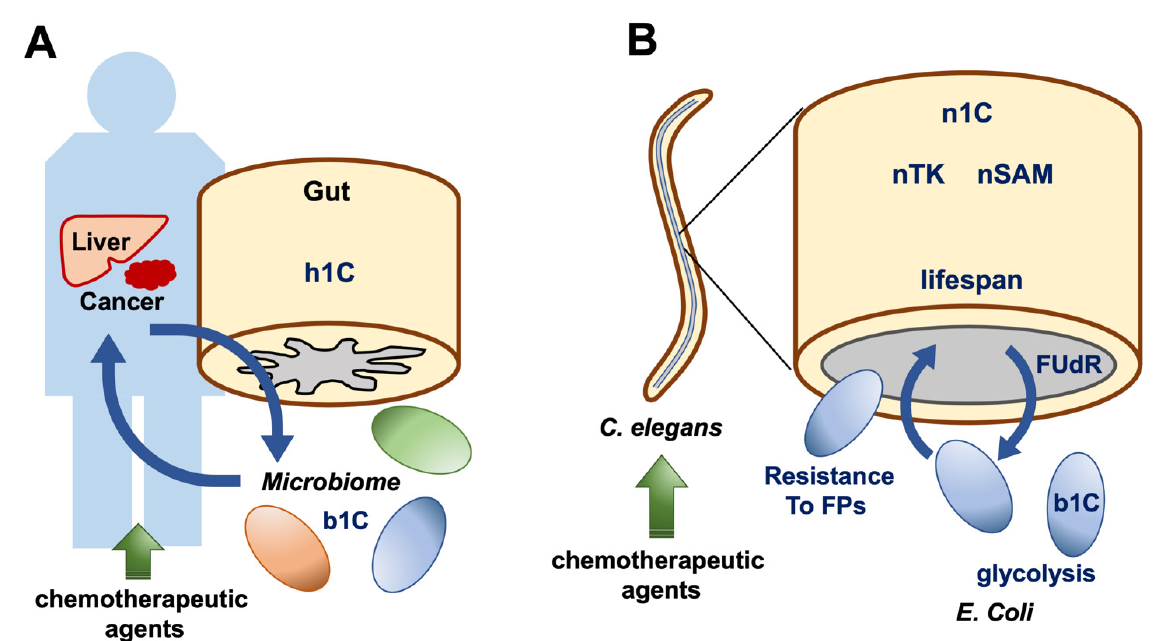
Figure 6. ( A ) Human gut in a patient with cancer: h1C, human one-carbon metabolism; b1C, bacterial one-carbon metabolism. ( B ) An animal model using Caenorhabditis elegans to study 1C metabolism in the microbiome. In the intestines of nematodes, bacteria produce metabolites from b1C, which in turn fuel the host nematodes. Exposure to chemotherapeutic agents resulted in 1C alterations in nematodes and bacteria. Analysis of this model may give insights into mechanisms of microbiome-to-host interaction in humans. C. elegans , Caenorhabditis elegans ; n1C, nematode one-carbon metabolism; nTK, nematode tyrosine kinase; nSAM, nematode S-adenosyl methionine; FUdR, 5-fluoro 2 ′ -deoxyuridine; FPs, fluoropyrimidines; E. coli , Escherichia coli .